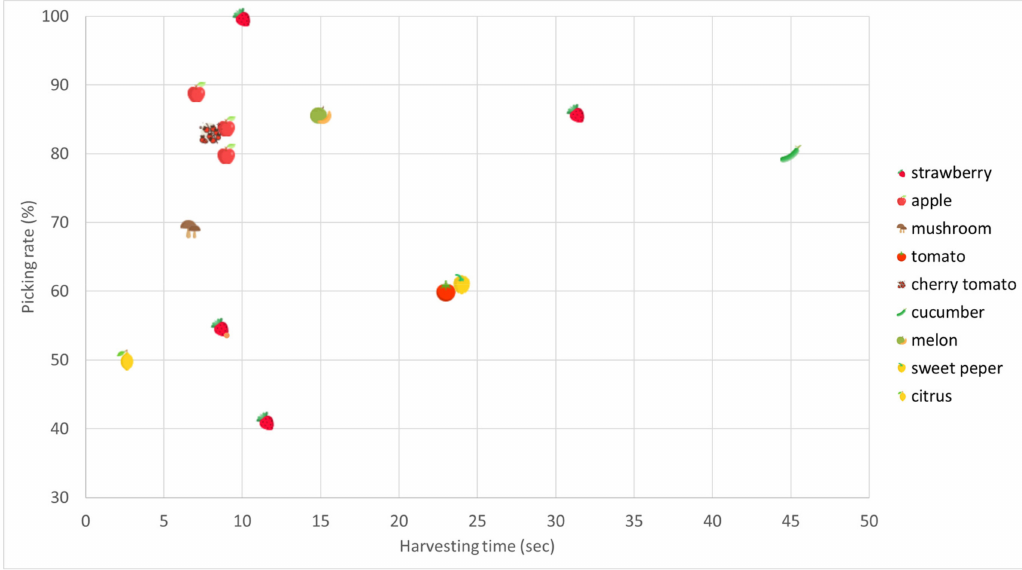
Figure 2. Global illustration of the reviewed robots’ overall